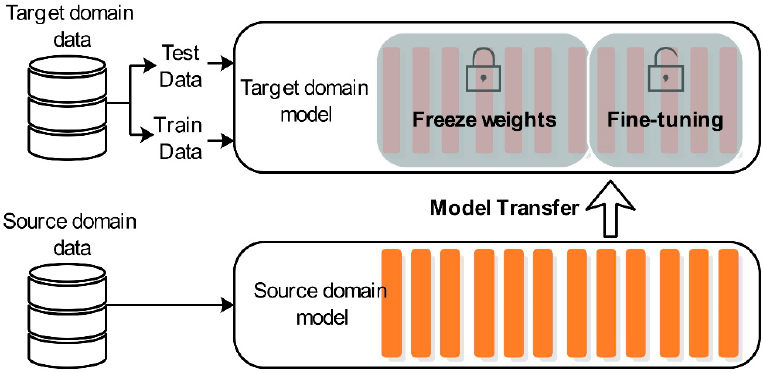
Figure 14. Using the target domain training set to fine-tune the unfrozen layer of the source model to obtain a new target model TL-TCN and then using the target domain test set to test the target model.